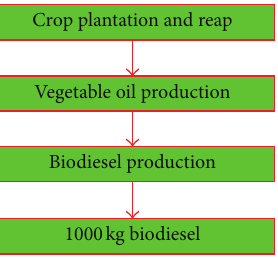
Figure 4: The system boundary of the biodiesel production system based on life cycle